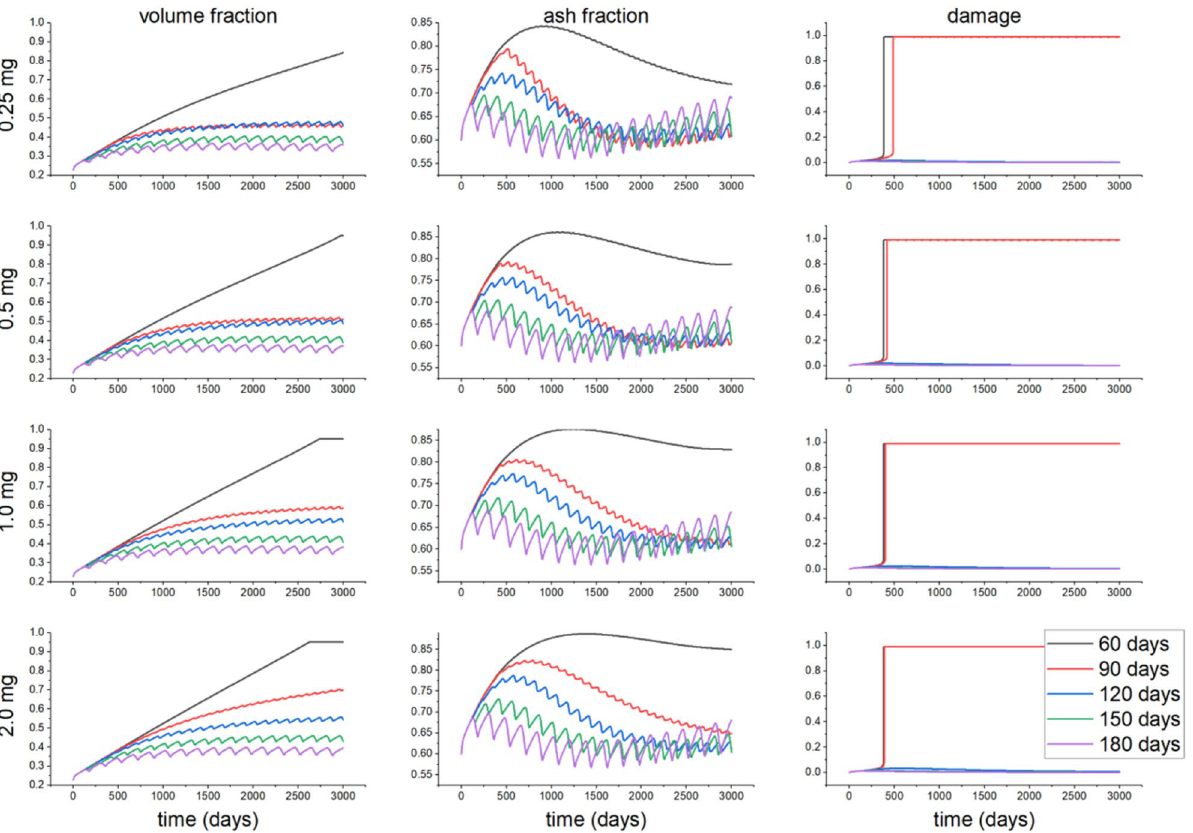
Figure 5. Evolution of the volume fraction, ash fraction and damage for different doses of Ibandronate (0.25, 0.5, 1.0 and 2.0 mg) when applying a stress of 1.0 MPa for a bone initial density of ρ dosage time intervals of 60, 90, 120, 150 and 180 days.